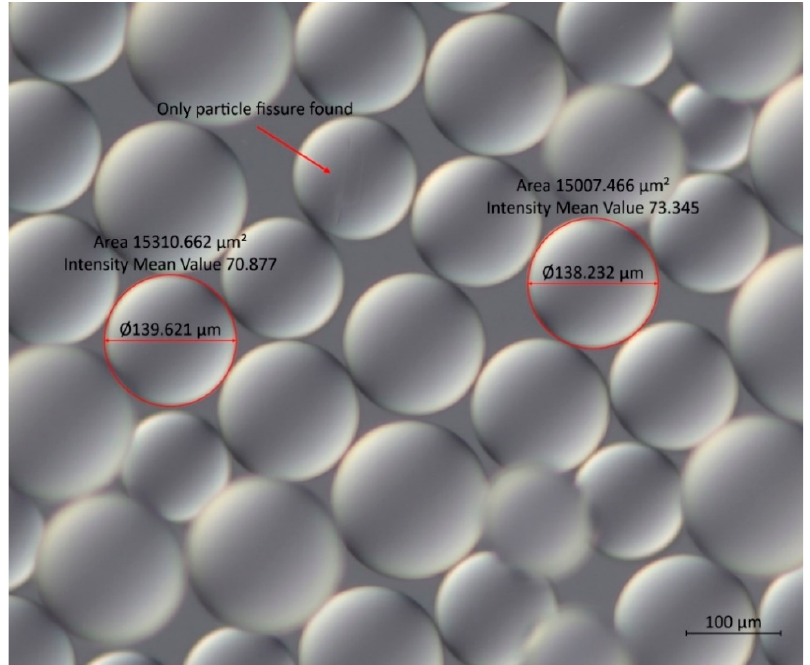
Figure 6. Microscopic image with DIC filter from particles of the Na+-form, showing the only deformation observed and two samples of the measurement taken from the particles.